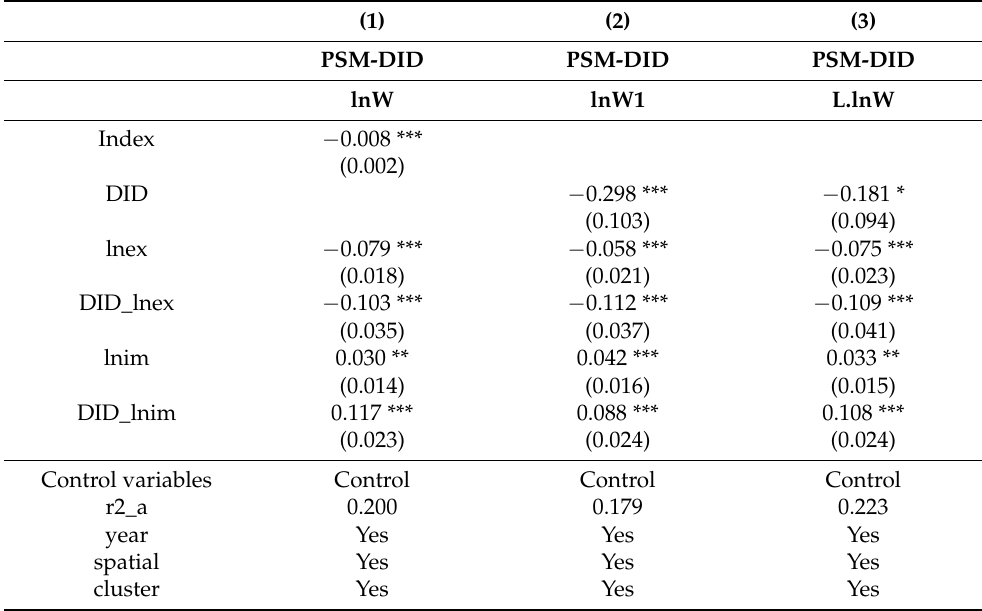
Table 3. Differing Measurements of